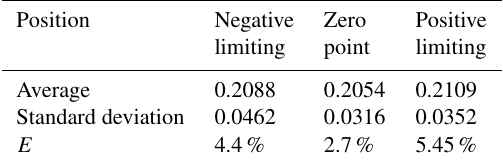
Table 1. Testing results around the X axis (µrad).